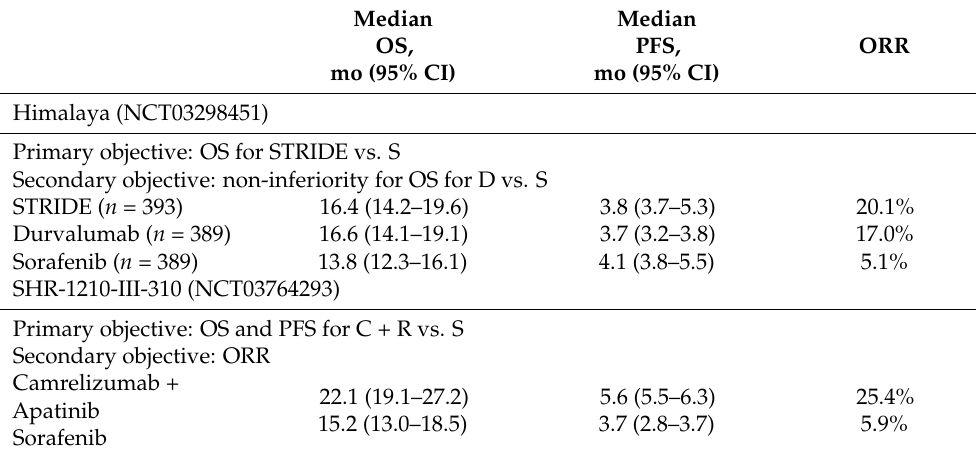
Table 2. First-line ICI combination phase III studies.